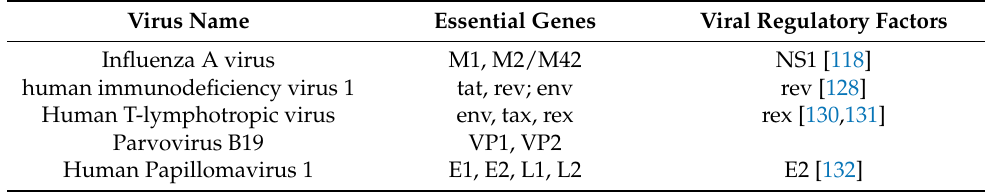
Table 3. Selected human pathogenic viruses with essential RNA splicing